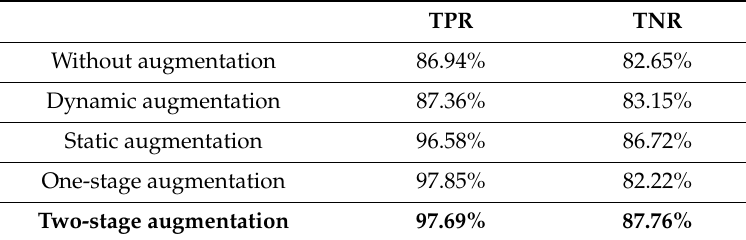
Table 6. Comparison of TPR / TNR of di ff erent augmentation methods.